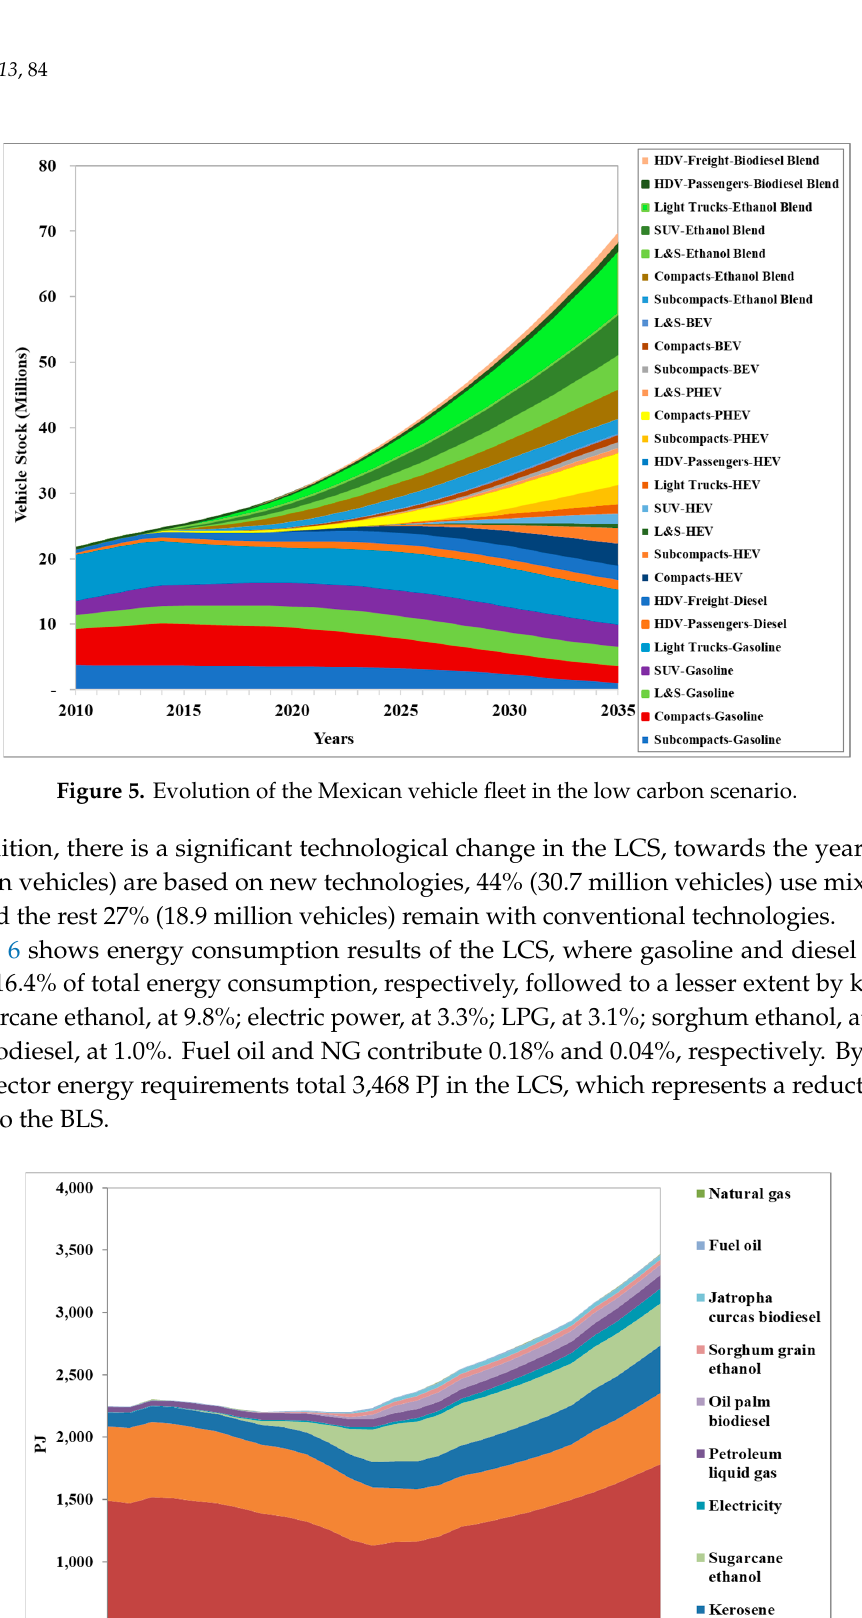
Figure 4. GHG emissions by energy carrier in the BLS.